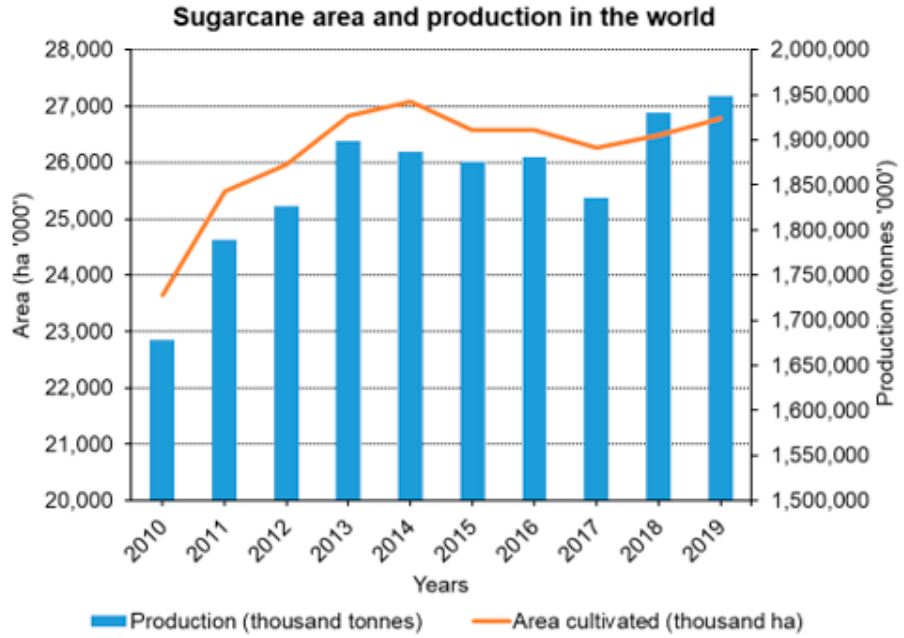
Figure 1. Worldwide sugarcane acreage and production from 2010 to 2019 (FAOSTAT, 2021).